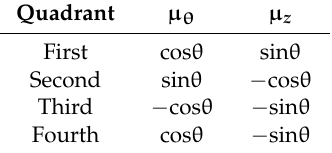
Table 3. Values of the influence coefficients in different quadrants.